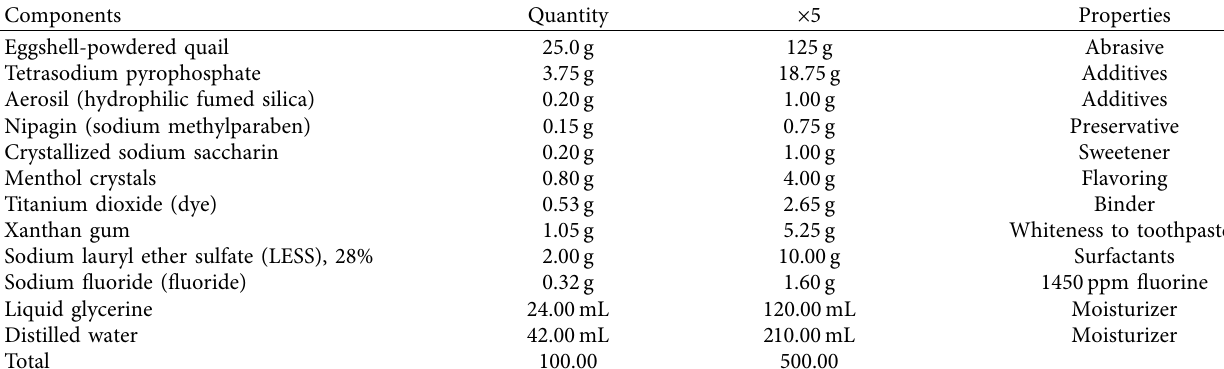
Table 1: Formulation and development of the experimental polishing dentifrice.